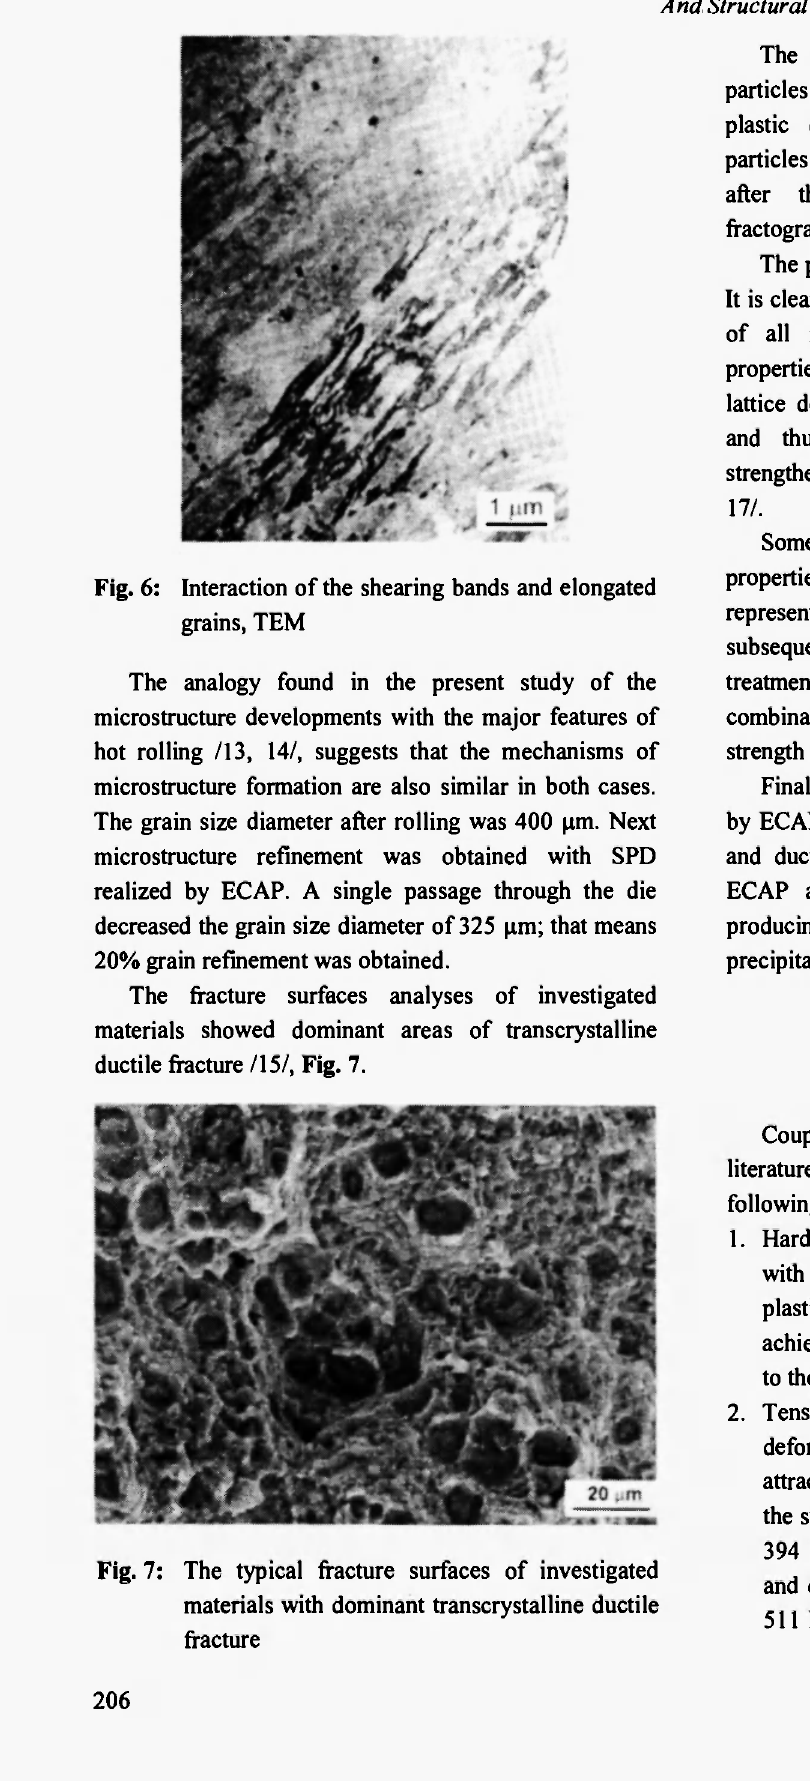
Fig. 7: The typical fracture surfaces of investigated materials with dominant transcrystalline ductile